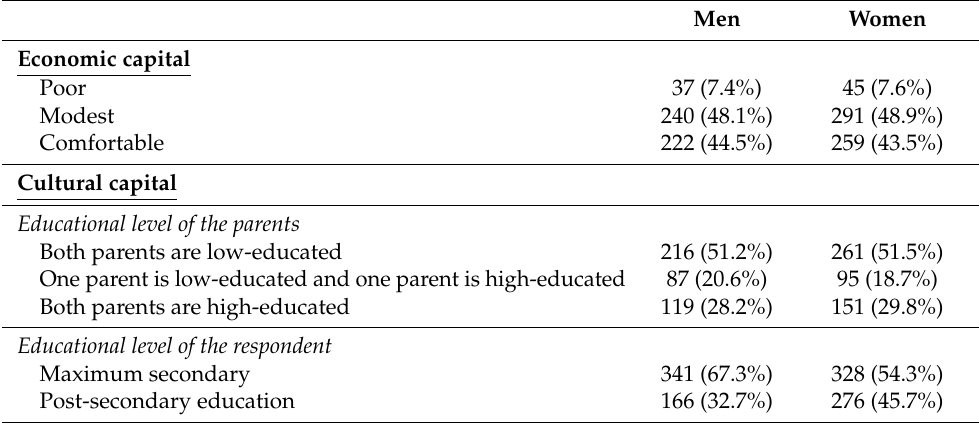
Table 1. Frequency of the different categories of economic and cultural capital for men and women— N